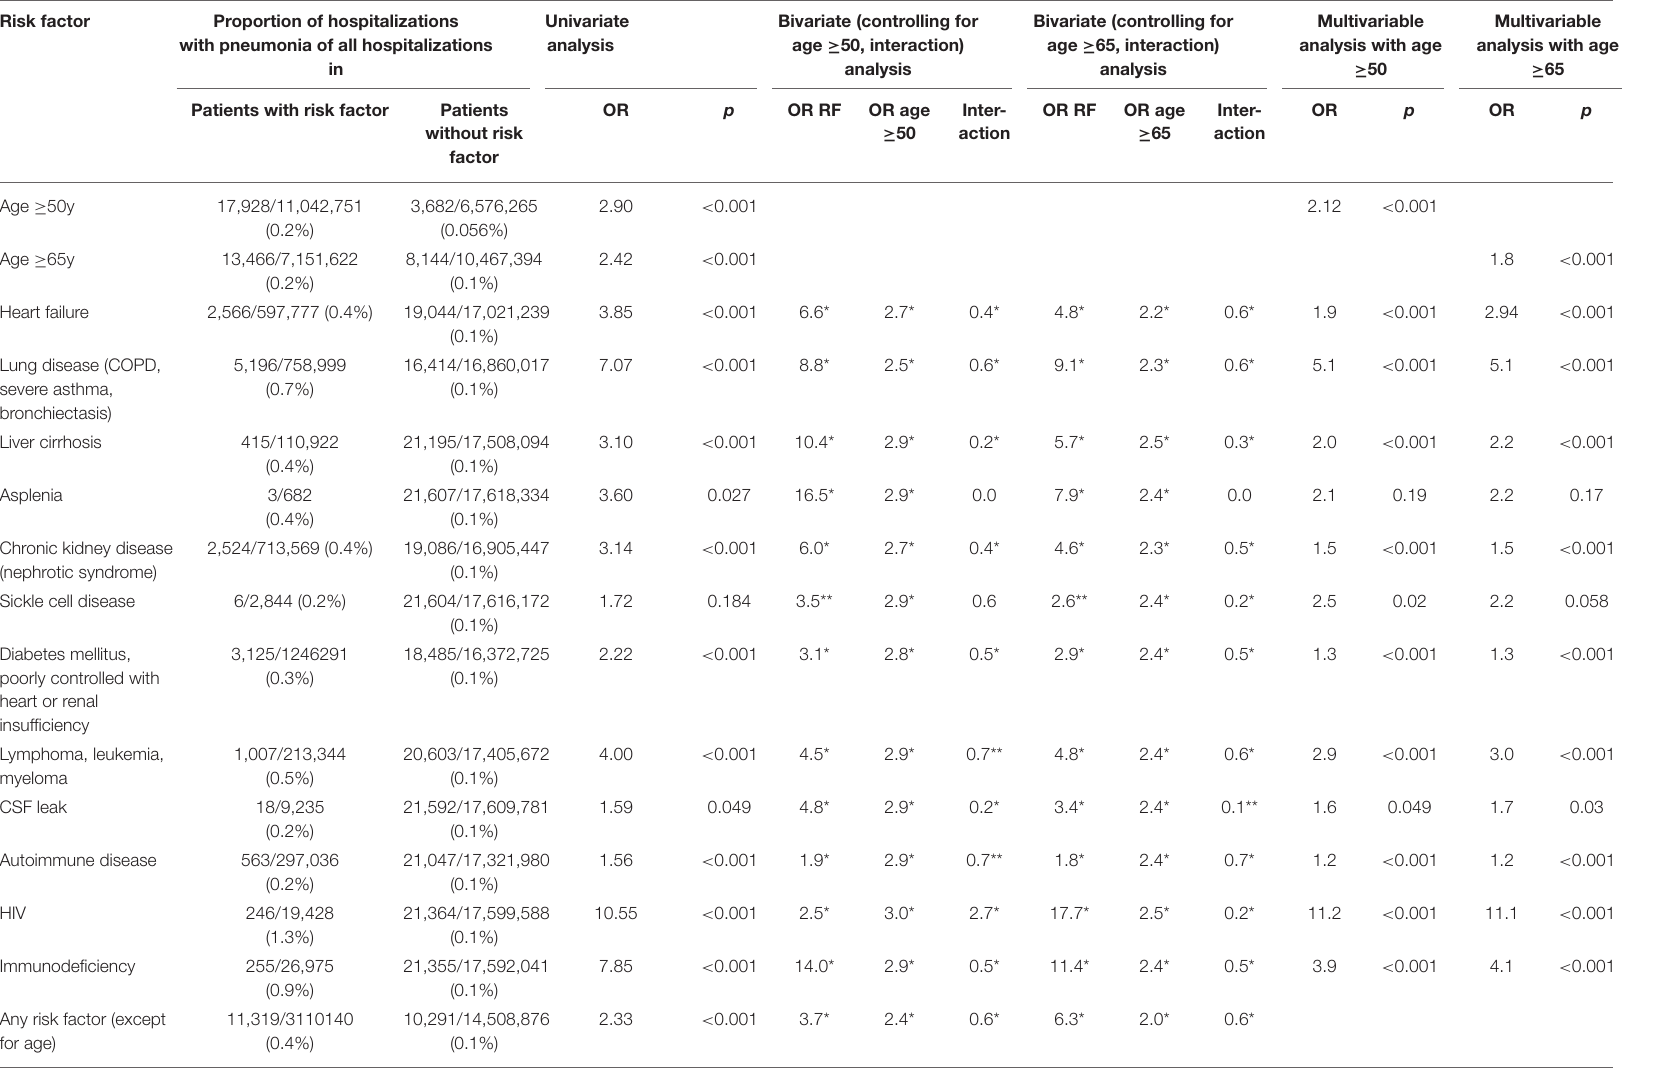
TABLE 1B | Hospitalizations with pneumococcal pneumonia in persons with and without risk factors. Risk factor Proportion of hospitalizations with pneumonia of all hospitalizations